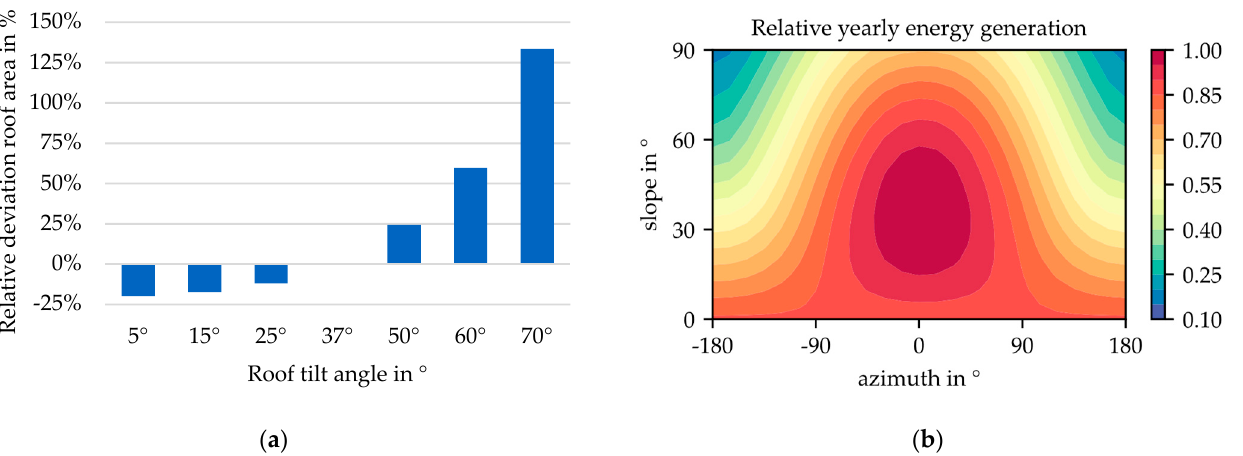
Figure 3. Relative deviation of roof area depending on roof tilt angle ( a ) and relative yearly energy generation ( b ) in comparison to a 37° tilted, south-facing roof surface located in Munich, Germany.